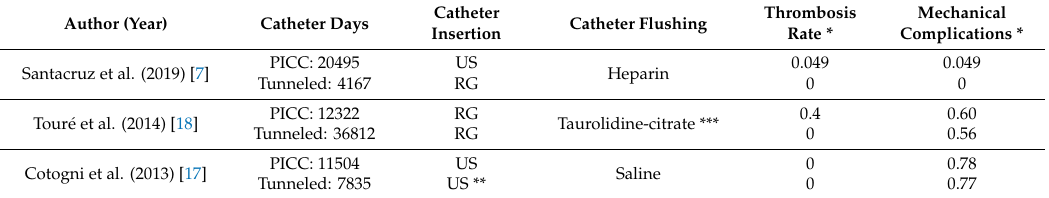
Table 3. Catheter-related non-infectious complications in PICCs vs. tunneled catheters.